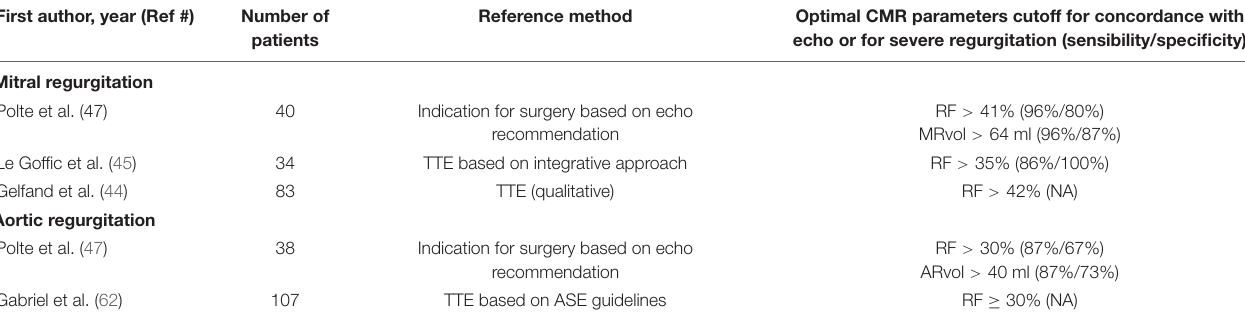
TABLE 5 | Relevant studies on validation of CMR parameters in MR and